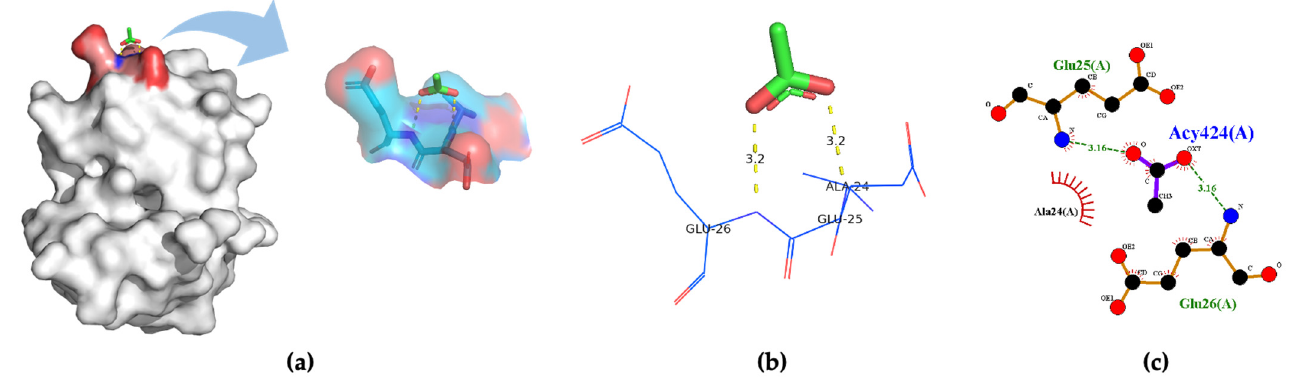
Figure 2. ( a ) 3D visualization of the docking model; ( b ) binding residues identification; ( c ) 2D ligand—protein interaction diagrams of AgamOBP20 (PDB ID:3VB1) bound to acetic acid.